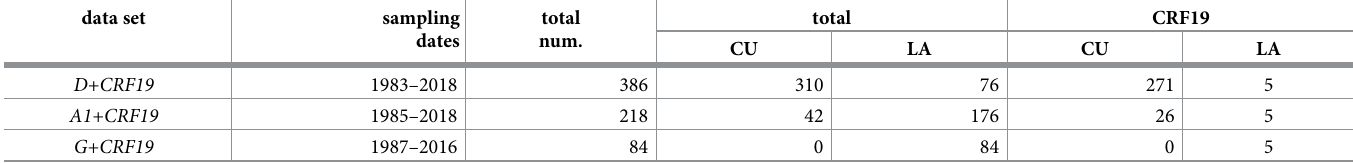
Table 1. Data set description: Subtypes and sources. Number of sequences of different subtypes and from different sources. LA data contained 6 sequences from Cuba: 3 of subtype G and 3 CRF19. data set